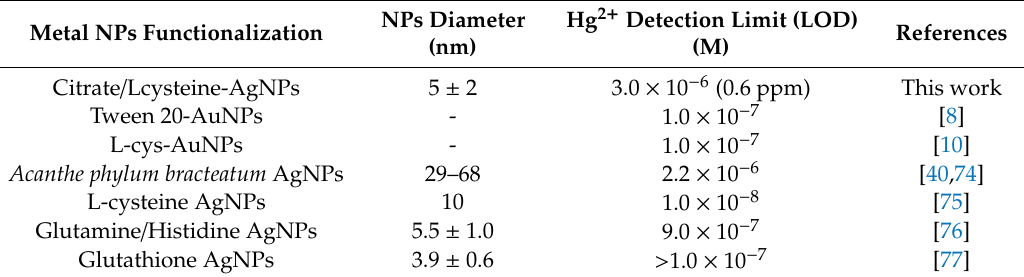
Table 2. Comparison between dimension and limit of detection (LOD) of some metal NPs used as a colorimetric sensor for the detection of Hg 2 + .